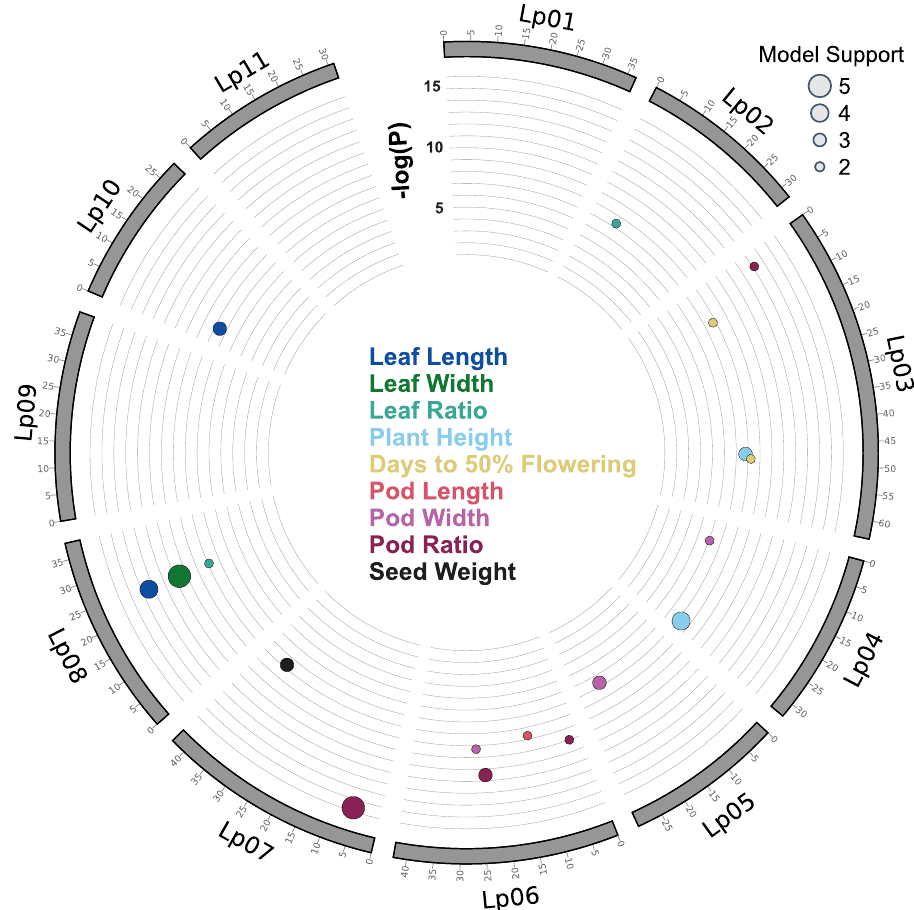
Fig.6|GWASinlablab. Circosplotsshowingthedistributionofsigni fi cantmarker- trait associations (MTA) identi fi ed in the lablab genome. Only signi fi cant markers with adjusted p -value>0.05 (after correcting for multiple comparison using False Discovery Rate approach) from at least two out of fi ve association models tested